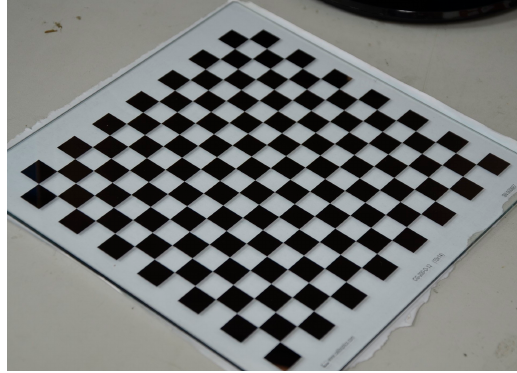
Figure 10. The glass calibration target.